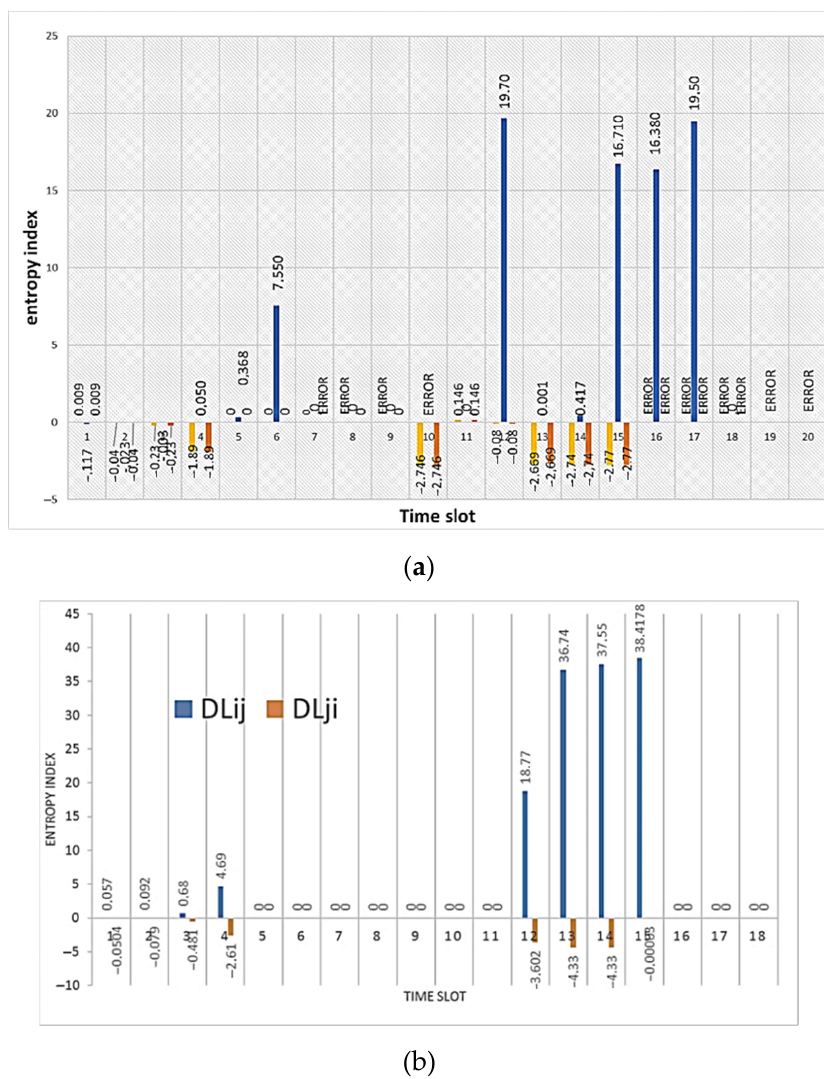
Figure 14. The result of calculating the entropy for: ( a ) received packets; and ( b ) packets sent by node i relative to node j (marked in blue) and by node j relative to node i (marked in orange) under conditions of a deauthentication attack.